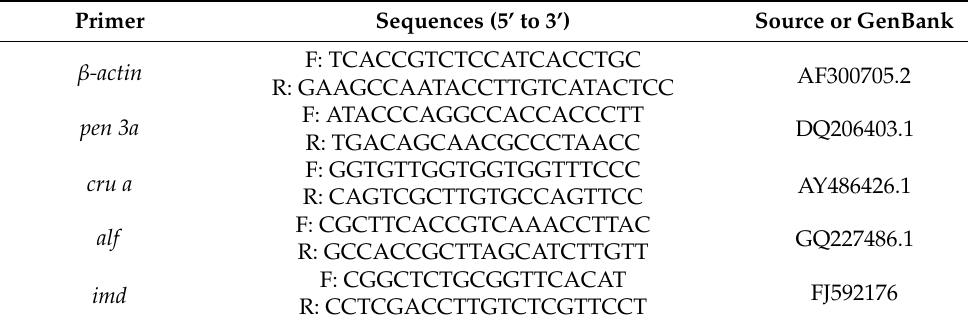
Table 3. Primers pair sequences used in real-time